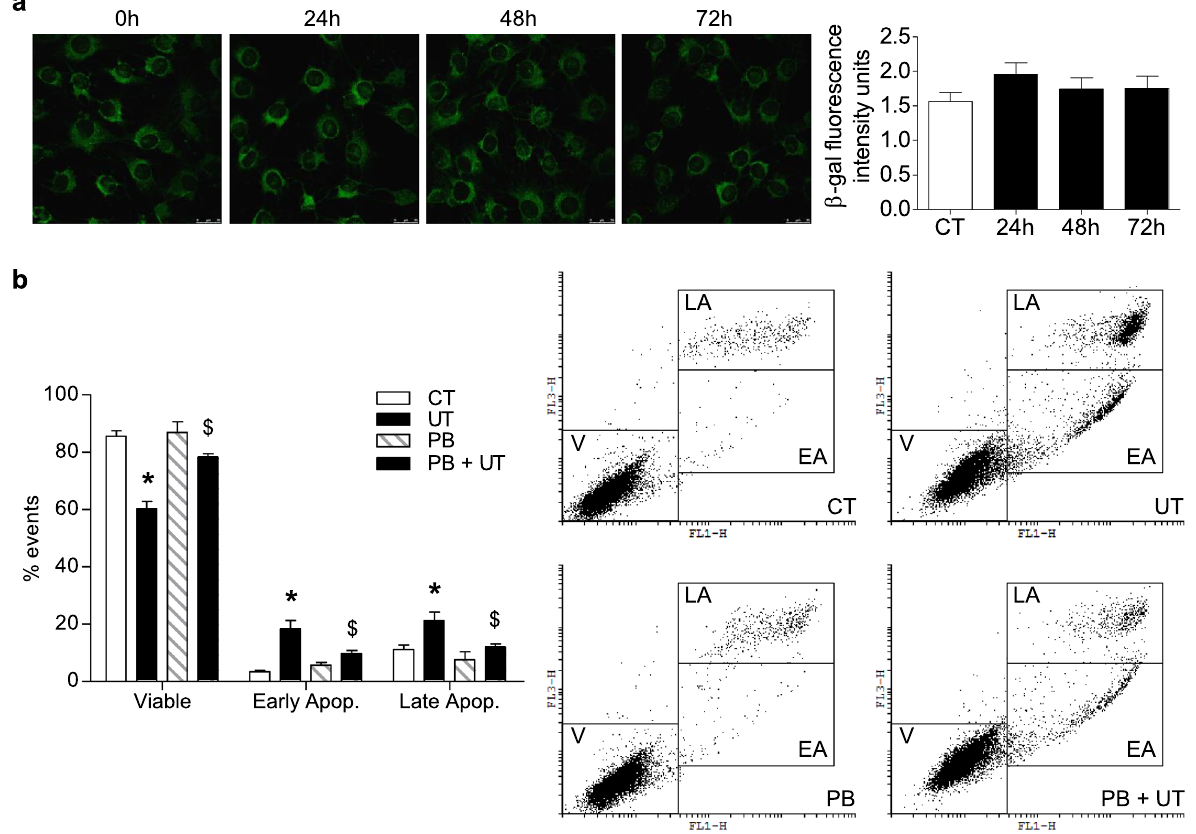
Figure 3. High doses of UT did not promote cell senescence, but they induced apoptosis in cultured myoblasts. ( a ) C 2 C 12 cells were treated with a mixture of 100 µg/mL IS and 100 µg/mL PC (UT) for 24, 48, or 72 h. Senescence-associated β-galactosidase activity was analysed using confocal microscopy using the fluorogenic substrate C 12 FDG. A representative experiment is shown. The bar graph represents mean ± SEM from ten experiments. ( b ) C 2 C 12 cells were treated with a mixture of 100 µg/mL IS and 100 µg/mL PC (UT) for 48 h in the presence or absence of 0.25 mM probenecid (PB). Apoptosis was analysed using the Annexin V test by flow cytometry. A representative experiment is shown. The bar graph represents the mean ± SEM from ten experiments. * p < 0.05 versus CT. $ p < 0.05 versus